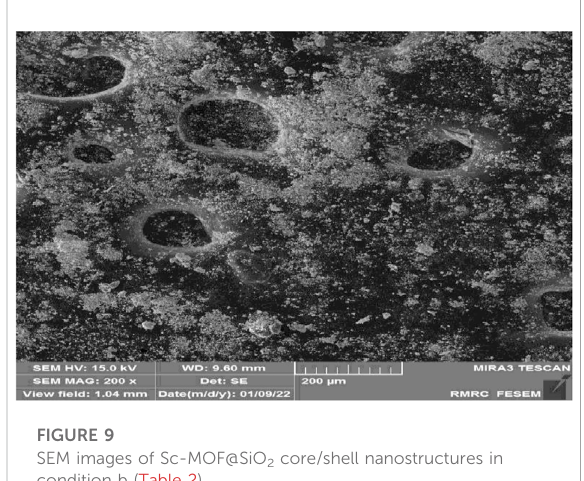
FIGURE 9 SEM images of Sc-MOF@SiO 2 core/shell nanostructures in condition b (Table 2).